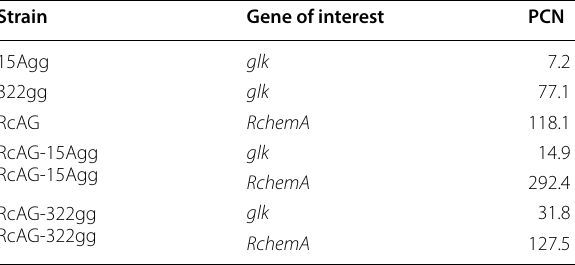
Table 2 Plasmid copy number of different strains Strain Gene of